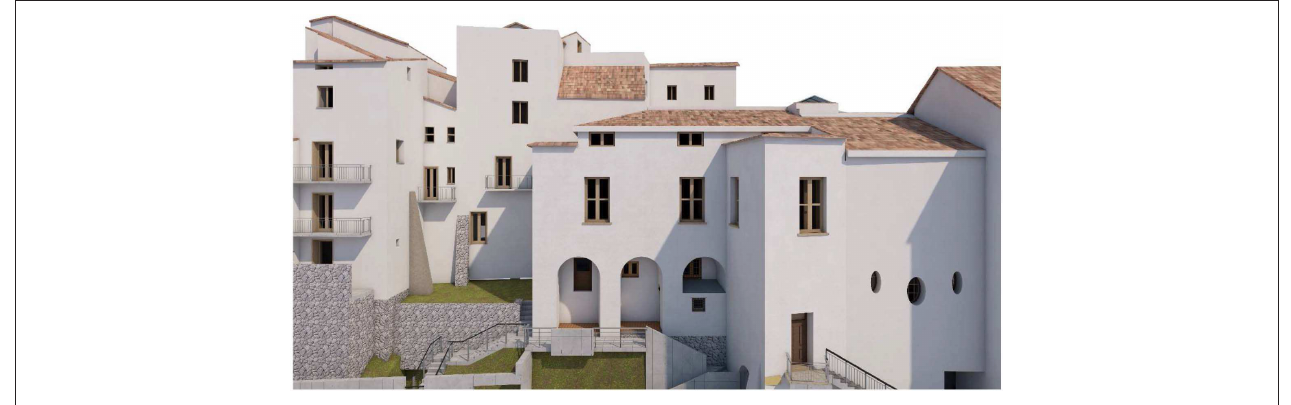
FIGURE 1 | Building south view.